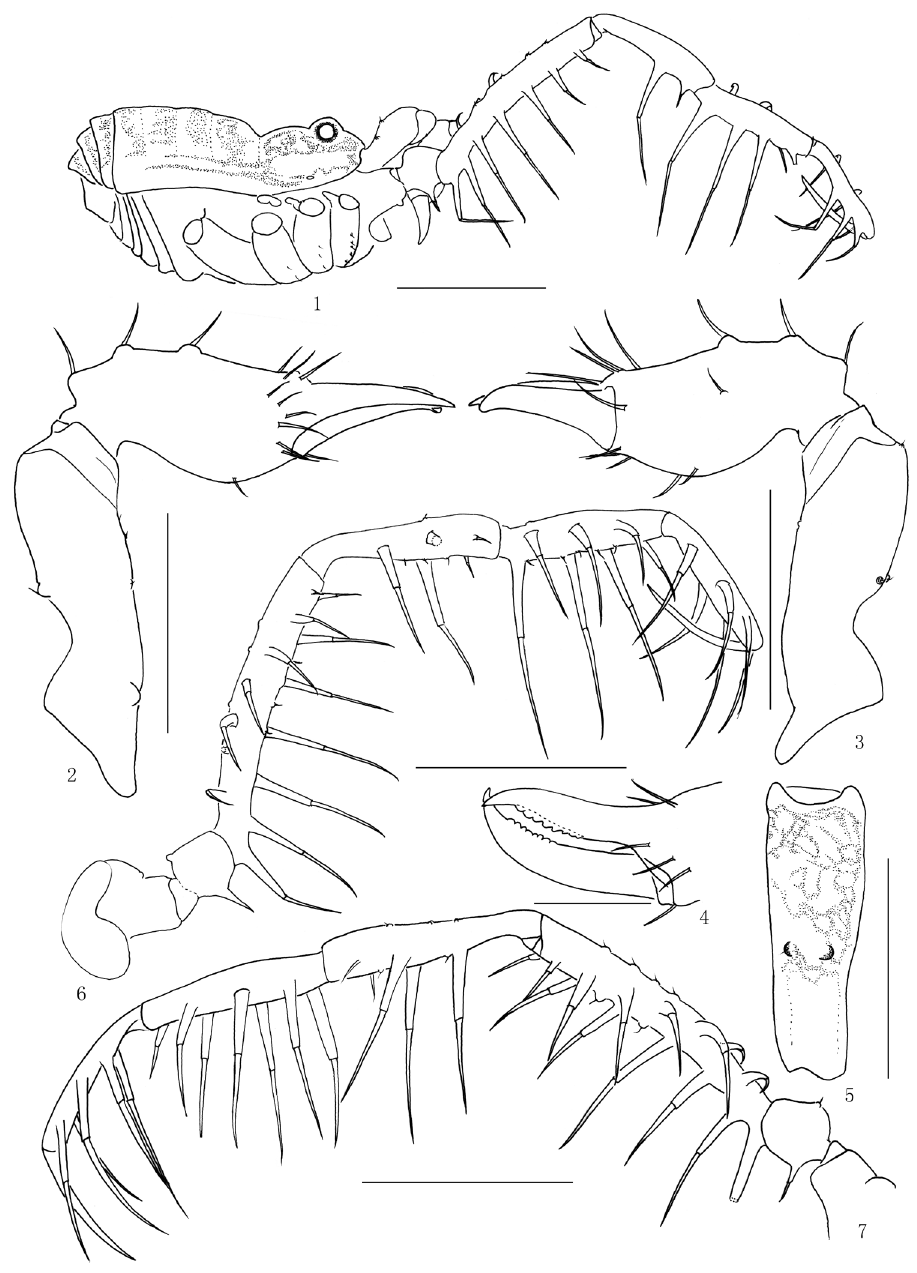
Figures 1–7. Lobonychium palpiplus Roewer, 1938, male (MHBU-Opi-20151208m) ( 1–6 ), female (MHBU-Opi-20151208f) ( 7 ) 1 Body, lateral view 2 Left chelicera, medial view 3 Same, ectal view 4 Cheliceral fingers, frontal view 5 Basal segment of left chelicera, dorsal view 6 Left pedipalp, medial view 7 Right pedipalp, medial view. Scale bars: 1mm ( 1, 6–7 ); 0.5 mm ( 2–3, 5 ); 0.25 mm ( 4